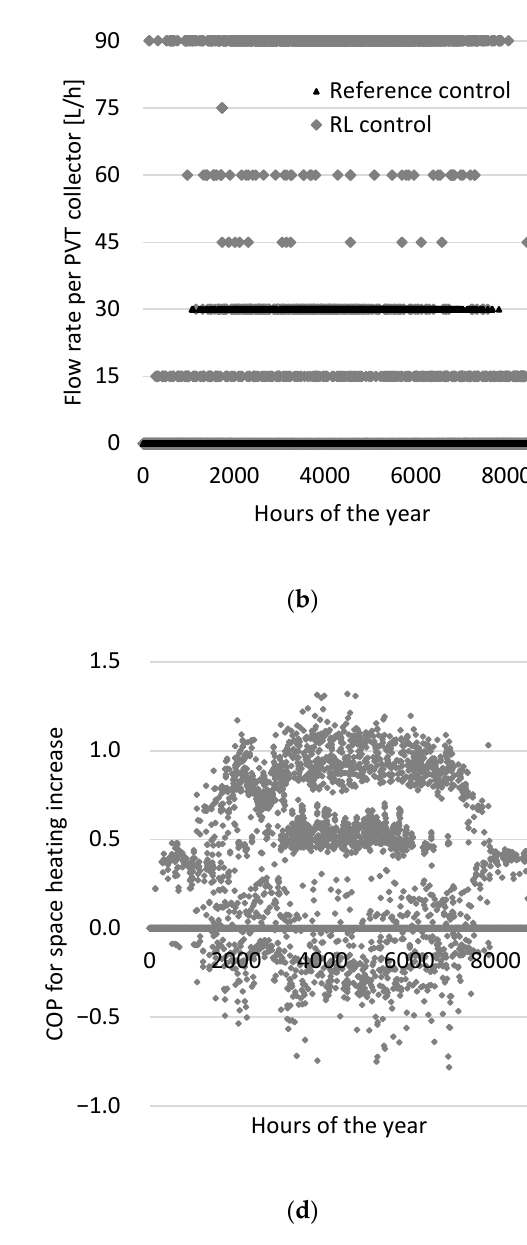
Figure 10. Results of the energy system model with reinforcement learning (RL) control compared to the reference control—Operating cost reduction ( a ), flow rate per PVT collector for reference and RL control ( b ), COP for domestic hot water increase ( c ), and COP for space heating increase ( d ).